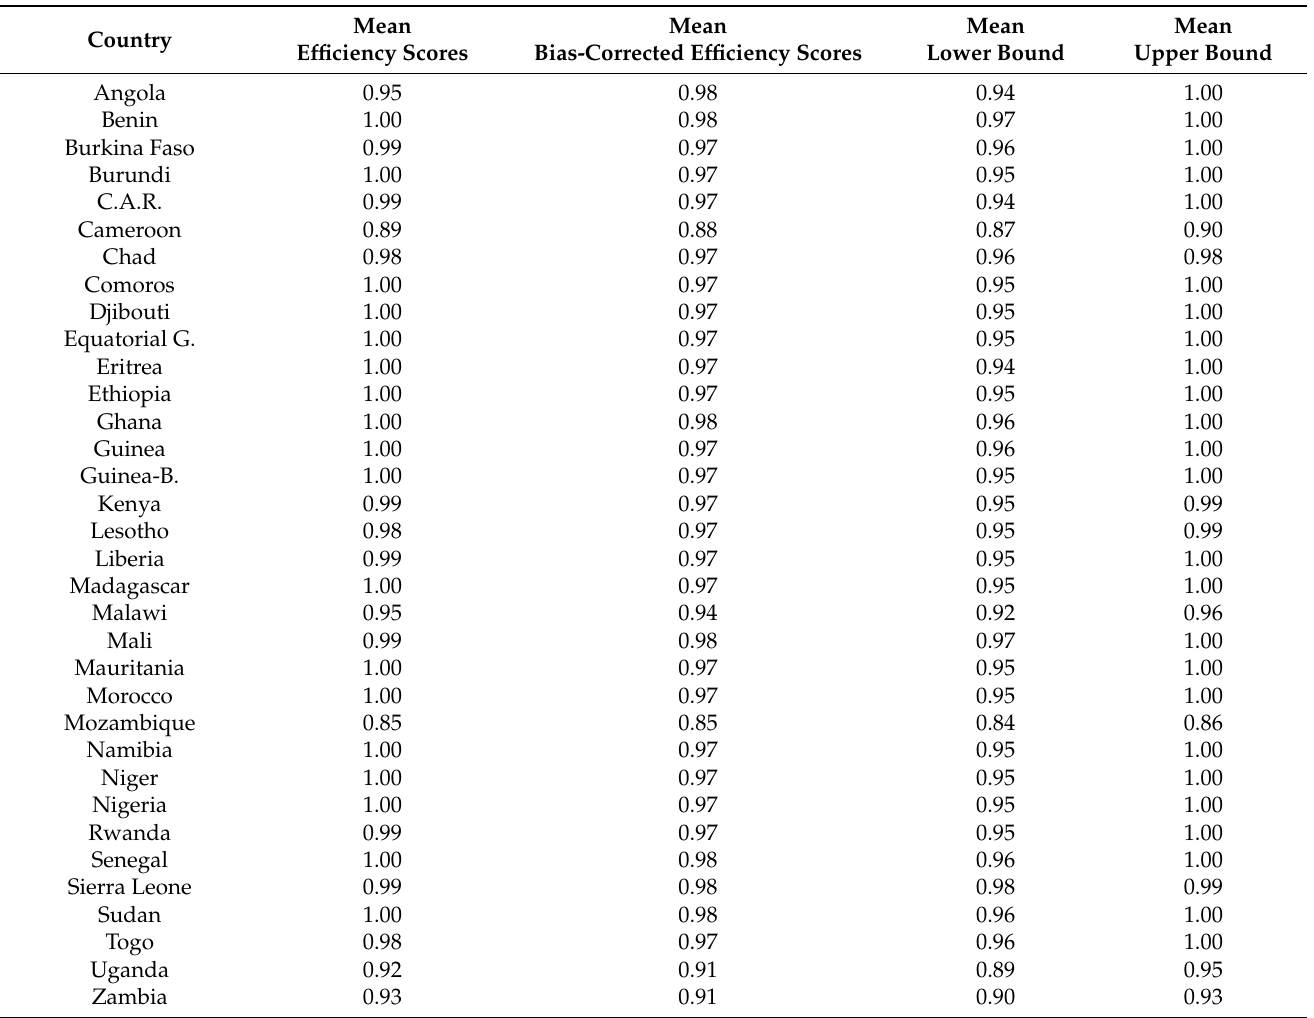
Table 4. Results for DEA 14 bootstrap calculations with B = 1000